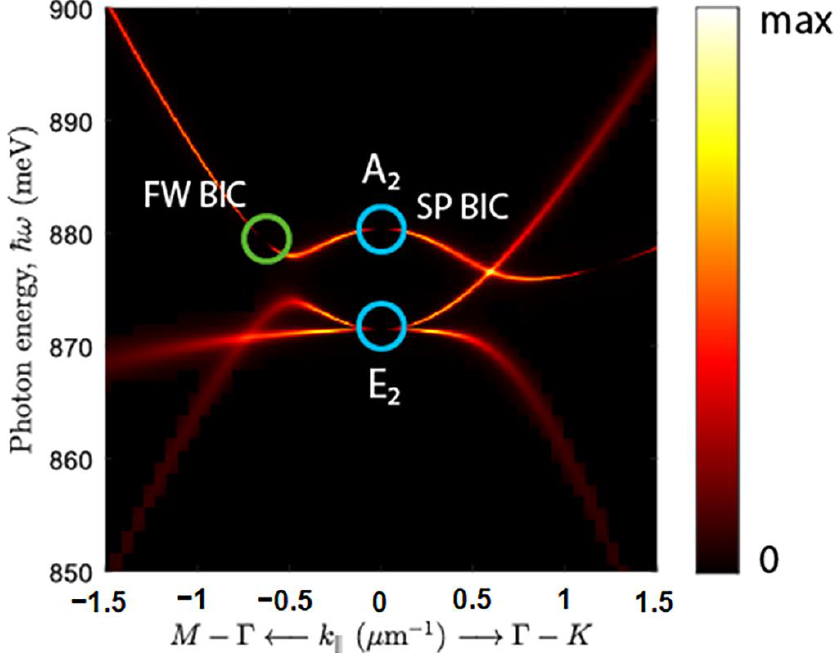
Figure 8. Calculated emissivity near modes A 2 and E 2 . Blue and green circles denote symmetry- protected (SP) and Fridrich-Wintgen (FW) BIC modes, respectively. Linear color scale is shown on the right.